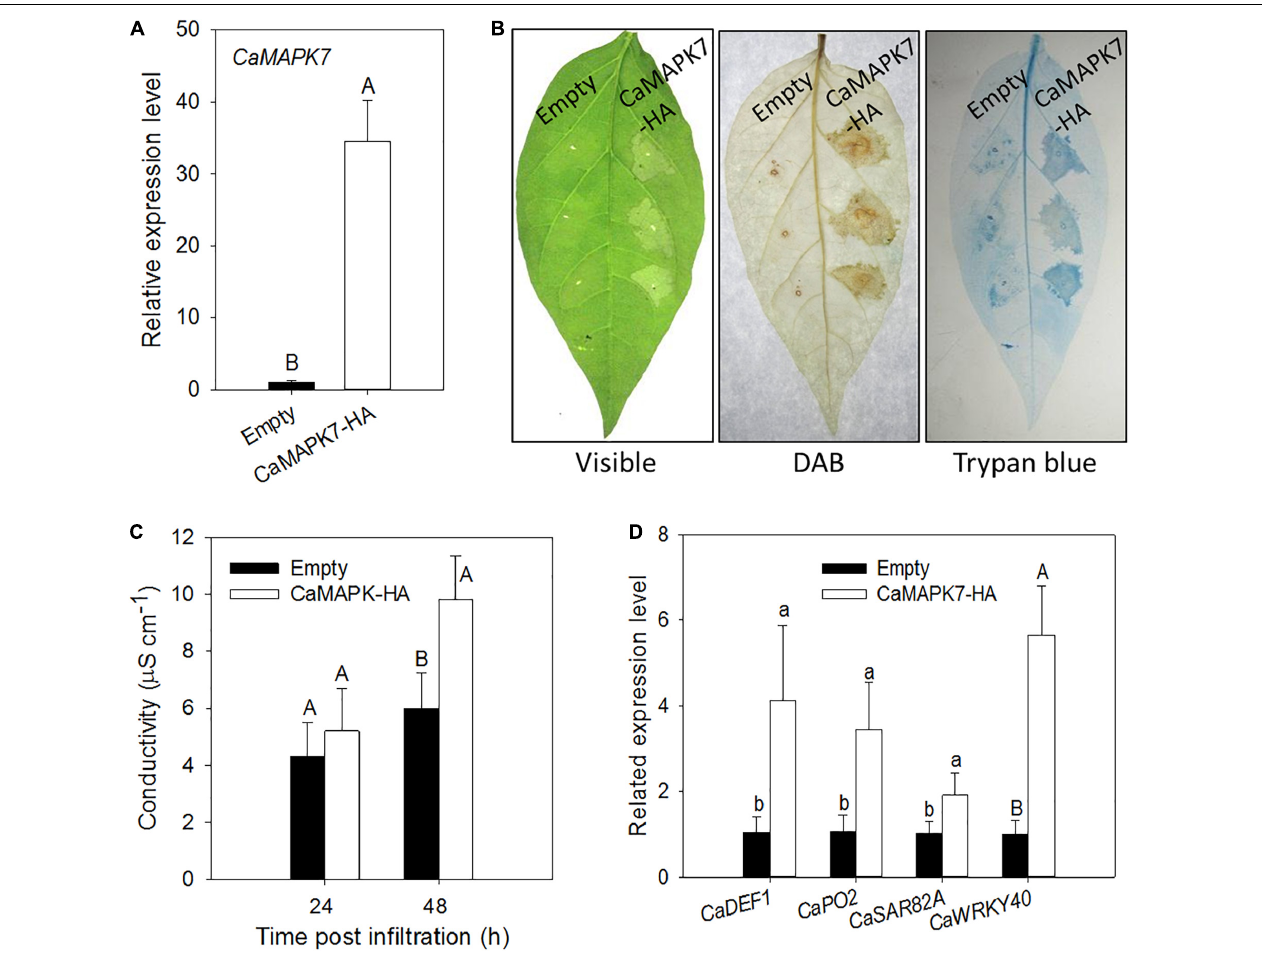
FIGURE 5 | Effects of the transient expression of CaMAPK7 on the cell death response of pepper leaves. (A) qRT-PCR analysis of transiently expressed CaMAPK7 in pepper leaves at 24 h post-agroinfiltration. (B) Induction of cell death and H 2 O 2 accumulation by transient CaMAPK7 expression in pepper leaves. The images of phenotype (left), trypan blue staining (middle), and DAB staining (right) were photographed 2 days post-agroinfiltration. (C) Electrolyte leakage from pepper leaves transiently expressing CaMAPK7 at 24 and 48 h after inoculation. (D) Real-time analysis of defense-associated marker genes in CaMAPK7 -transient expression pepper leaves. The relative expression level of defense marker genes in pepper plants transiently expressed empty vector were set to “1.” (C,D) Error bars indicate the standard error. Different letters above the bar show a significant difference between the means of the three biological replicates based on two-tailed t -test: uppercase letters, p < 0.01; lowercase letters, p < 0.05. DAB,